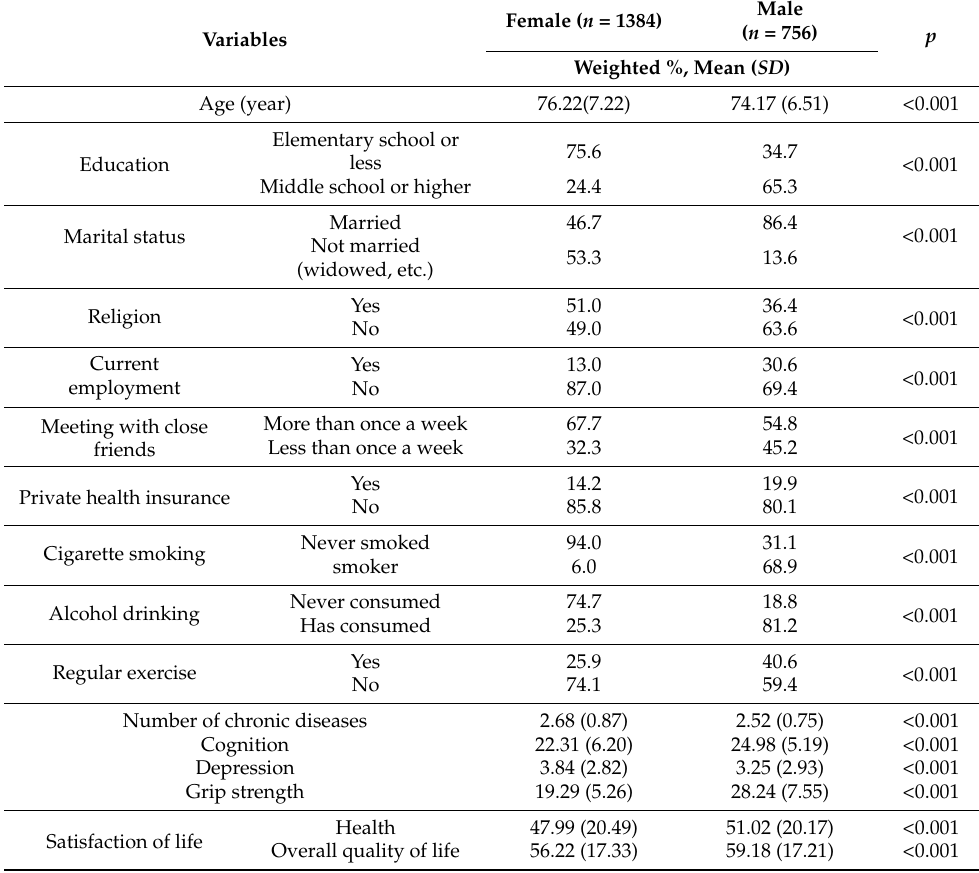
Table 1. Differences of variables by gender ( n =